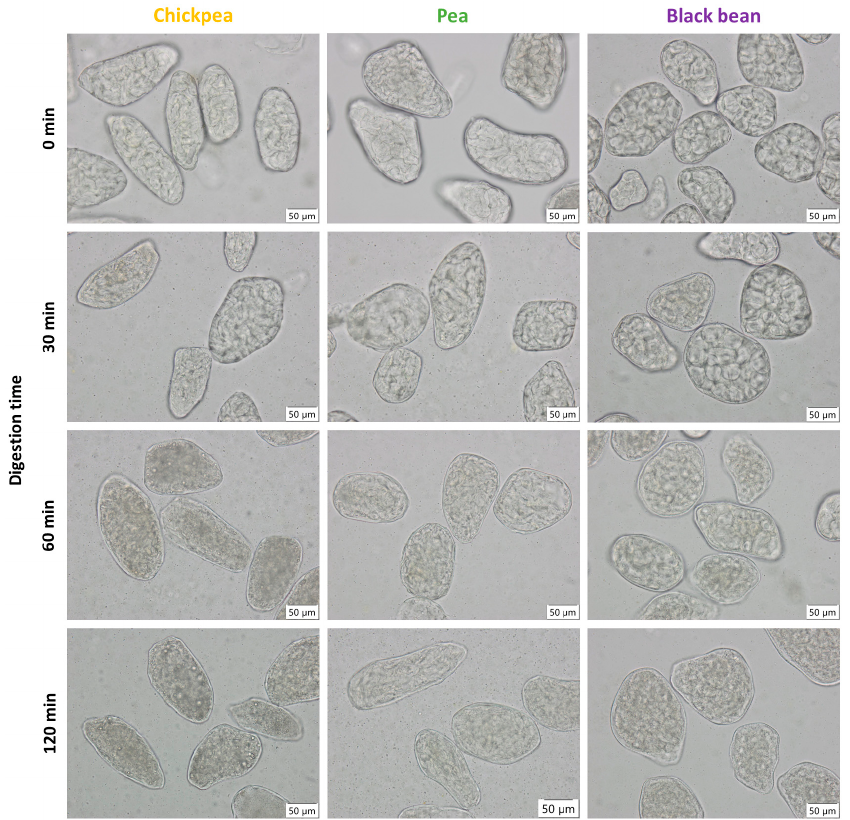
10 Figure 7. Representative microscopic images (scale bar: 50 µ m) of individual cotyledon cells (ICC) recovered after digestion (t = 0–120 min). Images were taken as a function of the in vitro simulated small intestinal digestion phase. Samples are cotyledon cells isolated from chickpea (CP), pea (PE), or black bean (BB) hydrothermally treated for 30, 30, or 60 min,